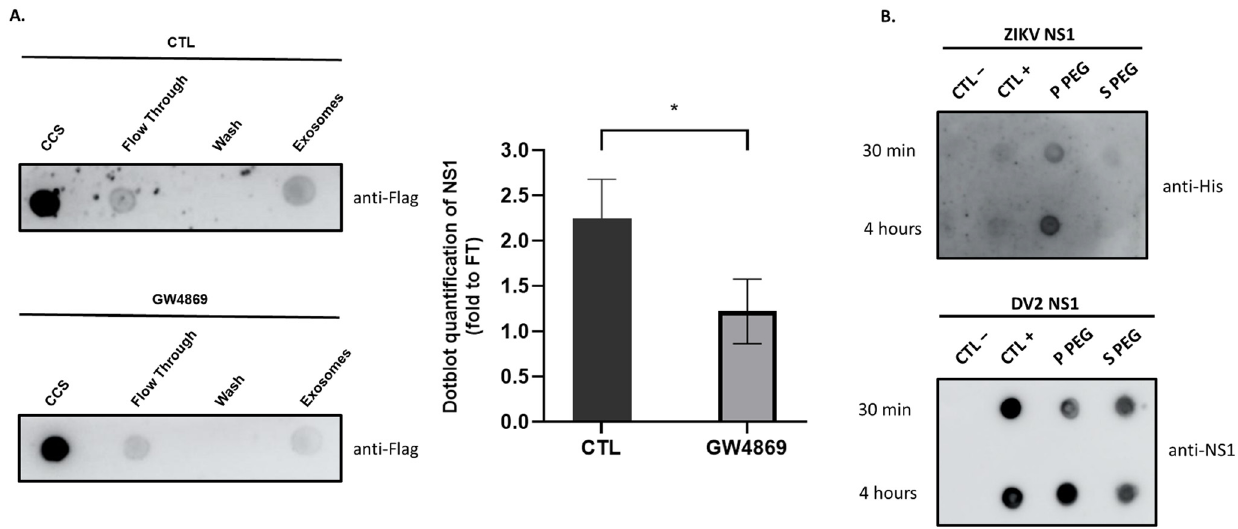
Figure 4. ZIKV and DV2 NS1 recombinant proteins bind to extracellular vesicles. ( A ) HEK 293 cells expressing ZIKV-NS1 Flag–tag protein were treated or not with GW4869 at 10 µ M for 16 h in order to inhibit exosome’s biogenesis. The cell culture supernatant (CCS) was collected for exosomes extraction using the Exoeasy kit. A dot blot was performed using anti-Flag and then quantified using imageJ. The flow through (FT) is the remaining part of the first exosome extraction step, and the wash is the second flow through, considered as a negative control. The quantity of NS1 associated with exosomes was reduced when cells were treated with GW4869, thus eliminating the co-elution bias of NS1 protein with exosomes. Unpaired t-test was performed using GraphPad Prism, * p < 0.05. ( B ) CCS of HEK was collected 48 h post-platting and incubated with ZIKV-NS1 HIS-tag or DENV2-NS1 HIS-tag for 30 min and 4 h. CCS was then proceeded to PEG exosome precipitation. The negative control (CTL − ) corresponds to panserin. The positive control (CTL+) corresponds to 0.2 ng of NS1 solubilized in panserin. Dot blots were performed using anti-His and anti-NS1 antibodies to detect ZIKV and DV2 NS1 proteins, respectively. NS1 of ZIKV and DV2 were found associated with EVs as early as 30 min